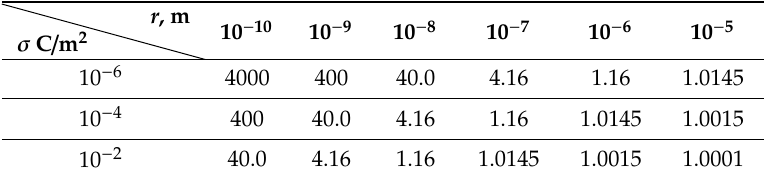
Table 1. Values of the coe ffi cient k = E d charged plane to the observation